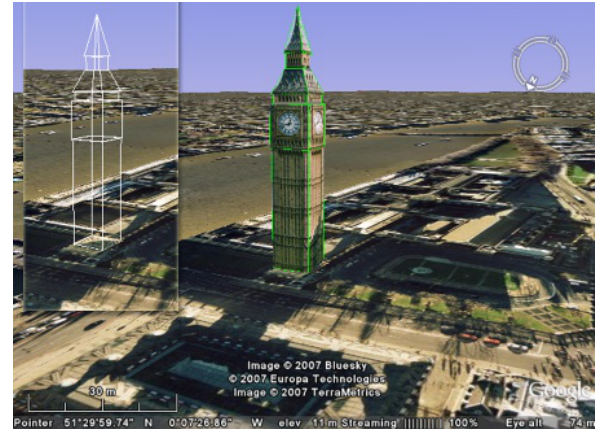
Figure 1. Google Earth Shot Showing data created by